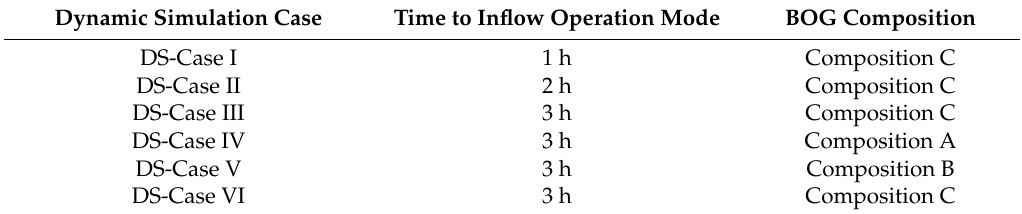
Table 4. Dynamic process simulation